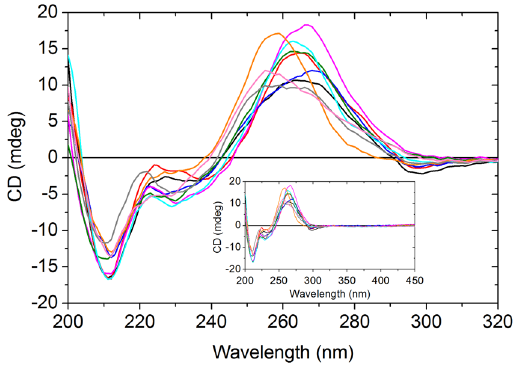
Figure 4. Circular dichroism spectra of nine RNA duplexes containing tC O . Duplexes are denoted by the bases neighbouring tC O according to Fig. 1b, and consist of the modified strands GG (black), UG (red), GU (blue), AA (orange), AU (pink), CC (gray), GUUU (purple), GAUU (green) and UUUG (cyan) hybridized to the complementary natural RNA strand. In the insert, the wavelength range is extended to 450 nm.